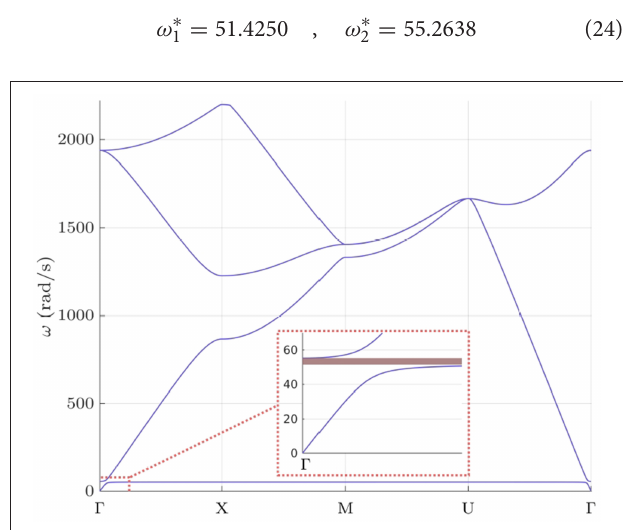
FIGURE 4 | Dispersion diagram for a periodic array (pitch d rigid shells (inner radius 0.3 m and outer radius 0.4 m) with one thin channel (length 0.1 m and radius 0.01 m) representing the frequency ω (rad.s − 1 ) of pressure waves in air vs. the wavenumber k Bloch vector k along the edges of the irreducible Brillouin zone Ŵ XMU